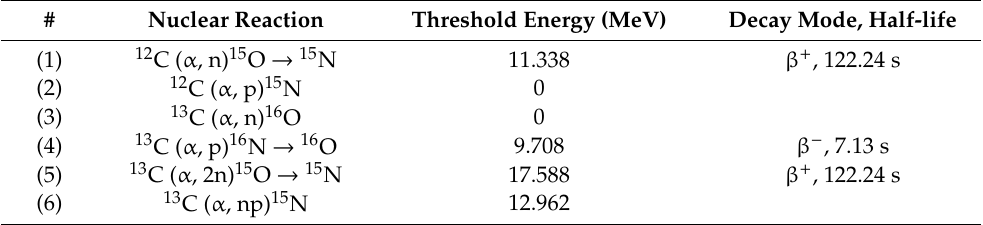
Table 1. Most possible nuclear reactions induced by 20 MeV He ion beam irradiation for polymers.